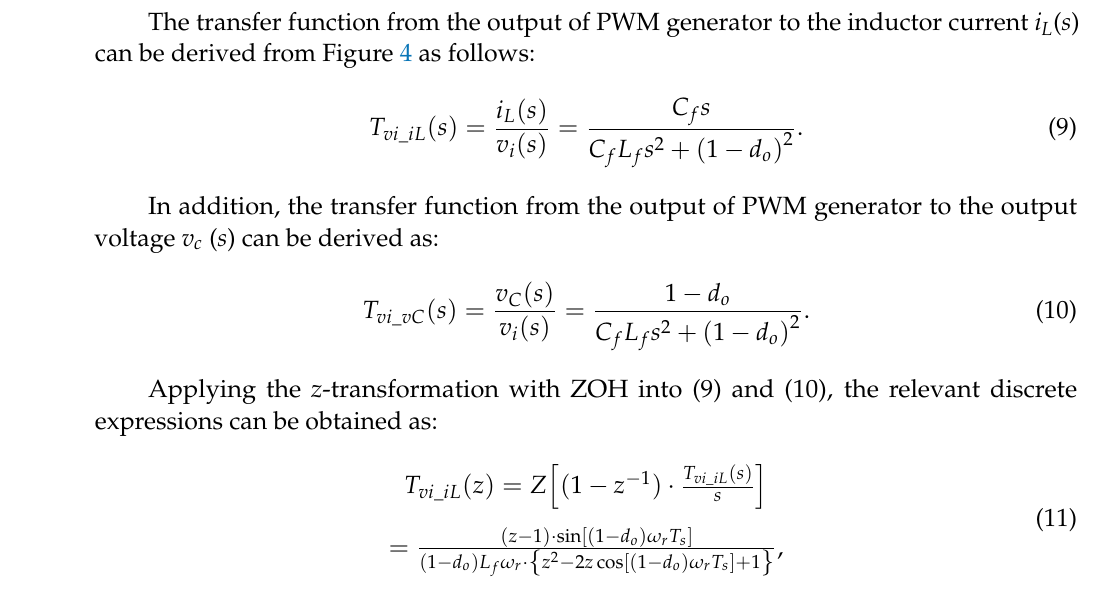
Figure 4. Overall control block diagram of the proposed buck–boost inverter.